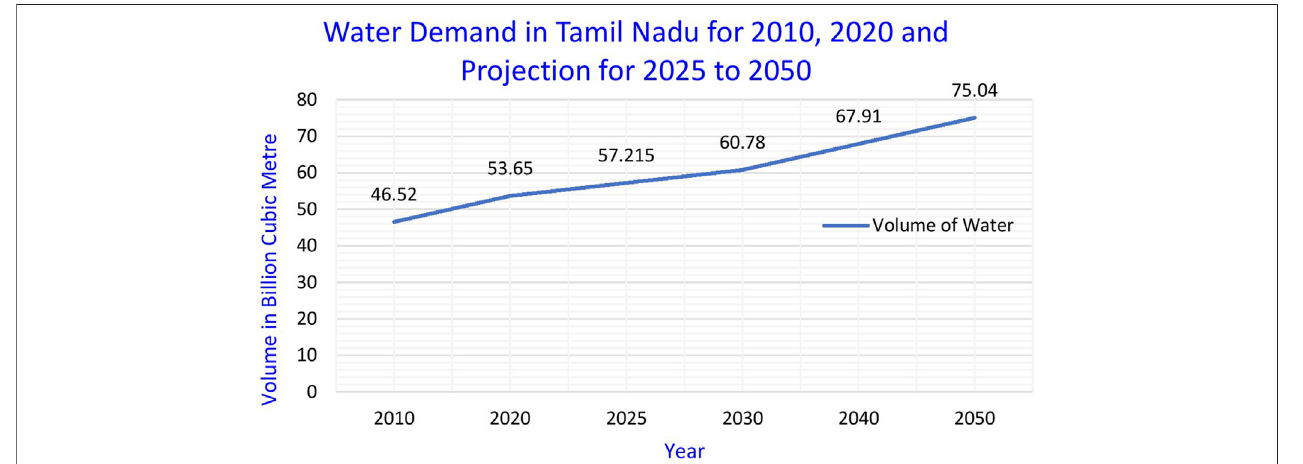
FIGURE 4 | Water demand in Tamil Nadu for 2010, 2020, and the projection for 2025 to 2050. Source: PWD, Chennai, India.